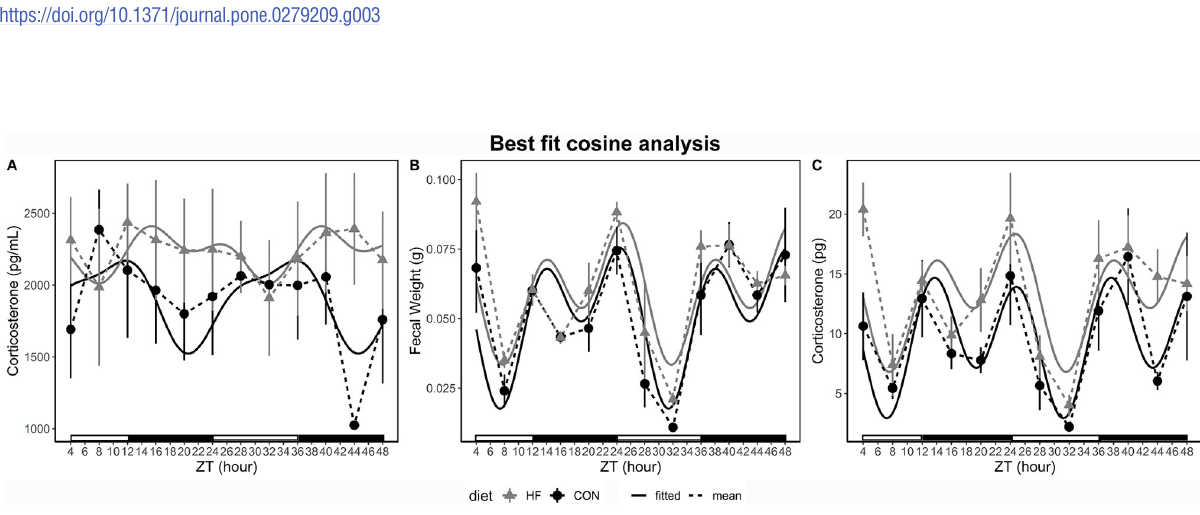
PLOS ONE | https://doi.org/10.1371/journal.pone.0279209 January 20,